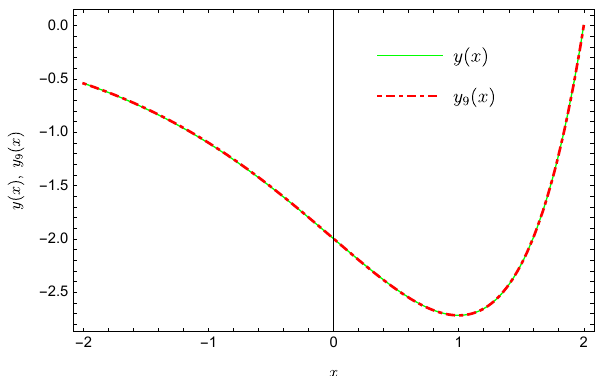
Figure 7. Exact solution and the approximate solution y 9 ( x ) .